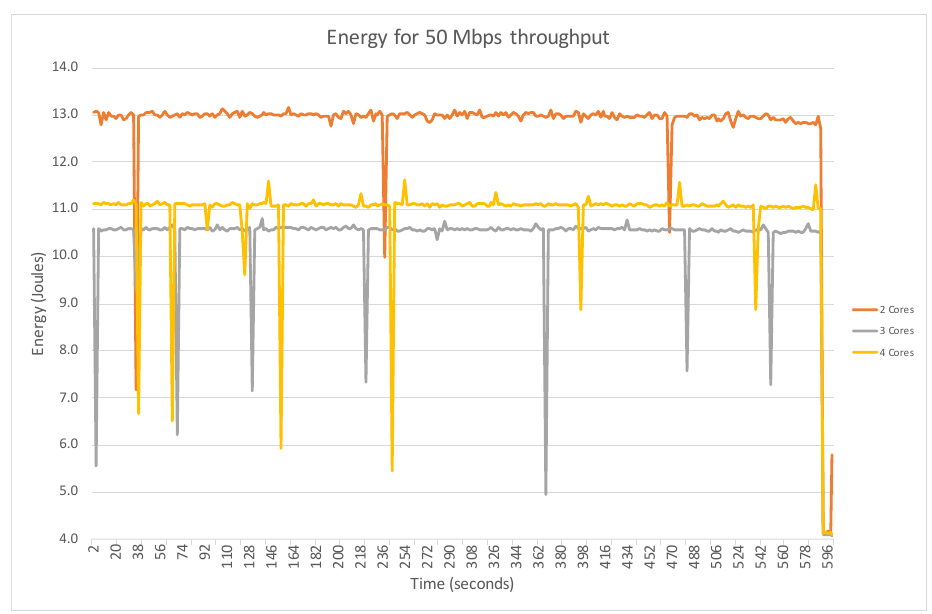
Figure 10. Energy consumed during the last second that proceeds the measurement for different number of cores during a 50 Mbps traffic.